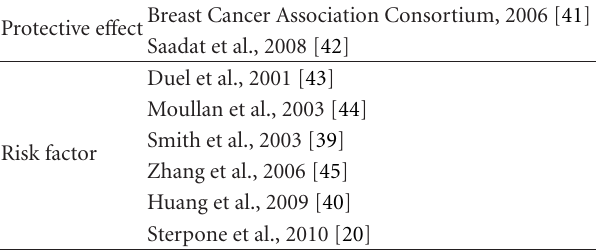
Table 2: Reported studies about the association of XRCC1-399 and BC risk. Breast Cancer Association Consortium, 2006 Protective e ff ect